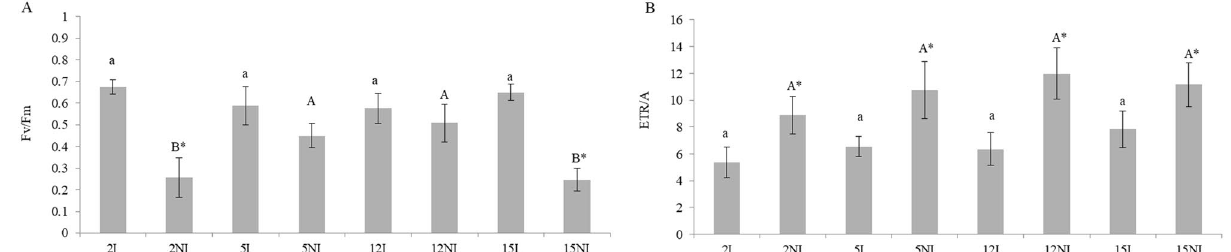
Figure 2. Maximum photochemical efficiency of PSII (Fv/Fm ratio) ( A ) and electron transport-to-net photosynthesis rate ratio (ETR/A) ( B ) of 4 irrigated (I) and non-irrigated (NI) progenies at 35 days of evaluation. Ranked results were analyzed using the non-parametric Kruskal–Wallis test followed by a pairwise comparison with the Mann–Whitney test. Significance level were established as p-values < 0.05, for both tests. Means followed by the same lowercase letter and averages followed by the same capital letter in each irrigation condition do not differ statistically from each other. Means followed by asterisks for even progeny